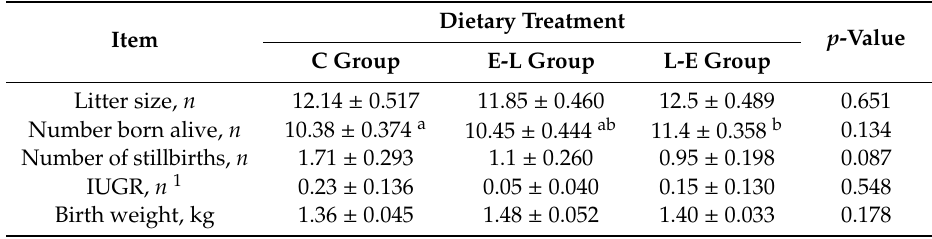
Table 5. The reproductive performance of sows ( n = 25).